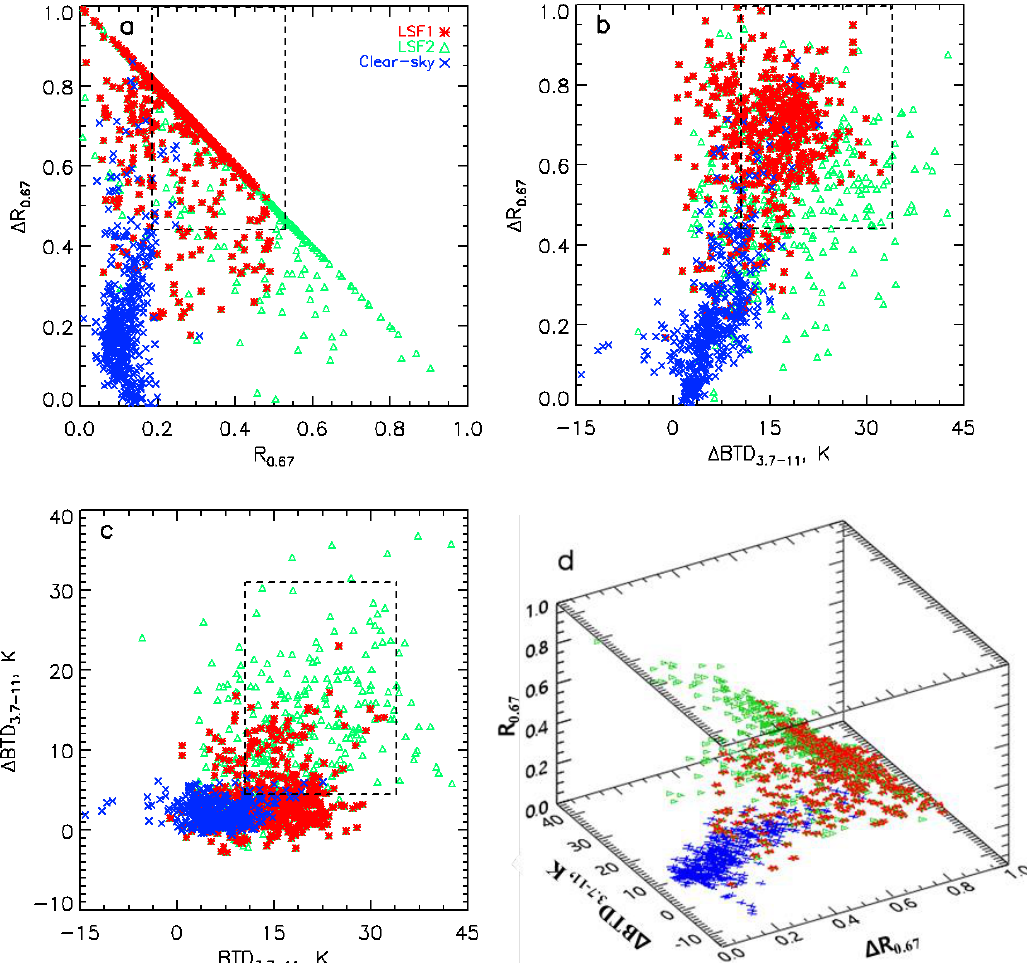
Figure 8. Scatter diagrams of satellite-observations. ( a ) ∆ R 0.67 vs R 0.67 , ( b ) ∆ R 0.67 vs ∆ BTD 3.7-11 , ( c ) ∆ BTD 3.7-11 vs BTD 3.7-11 , and ( d ) the 3D plot of the three variables ( ∆ R 0.67 , ∆ BTD 3.7-11 , and R 0.67 ) from the